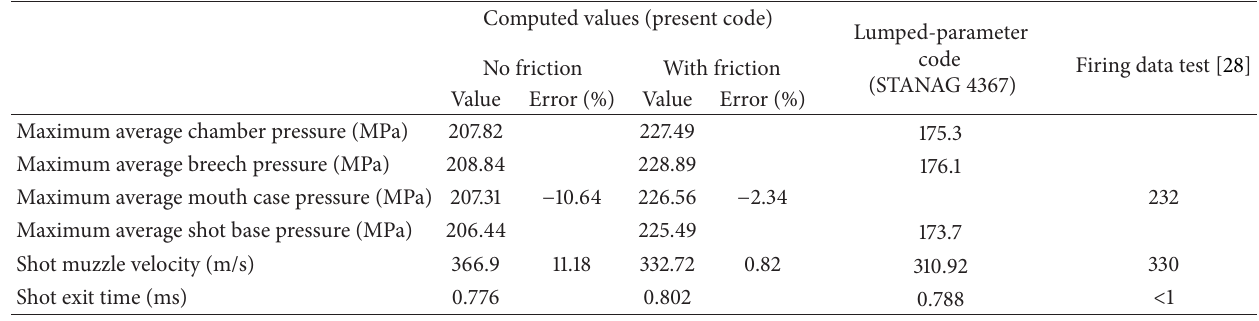
Table 2: Comparison of interior ballistic performance for charge weight of 0.245 g.